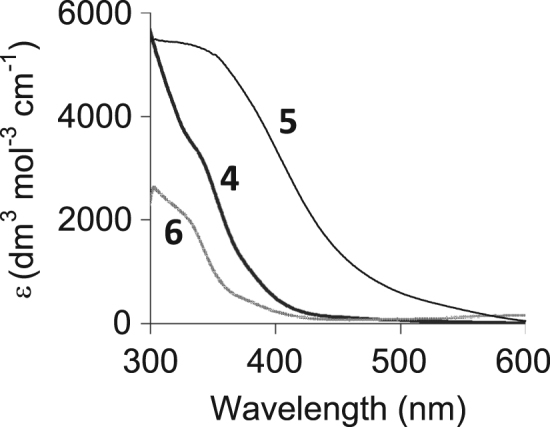
UV/vis spectra of the rhodium(I) complexes Rh(H3CCOCHCOCH3)CO(C6H5XPPh2), where X = O (4), S (5) and NH (6) at 25 °C in chloroform.